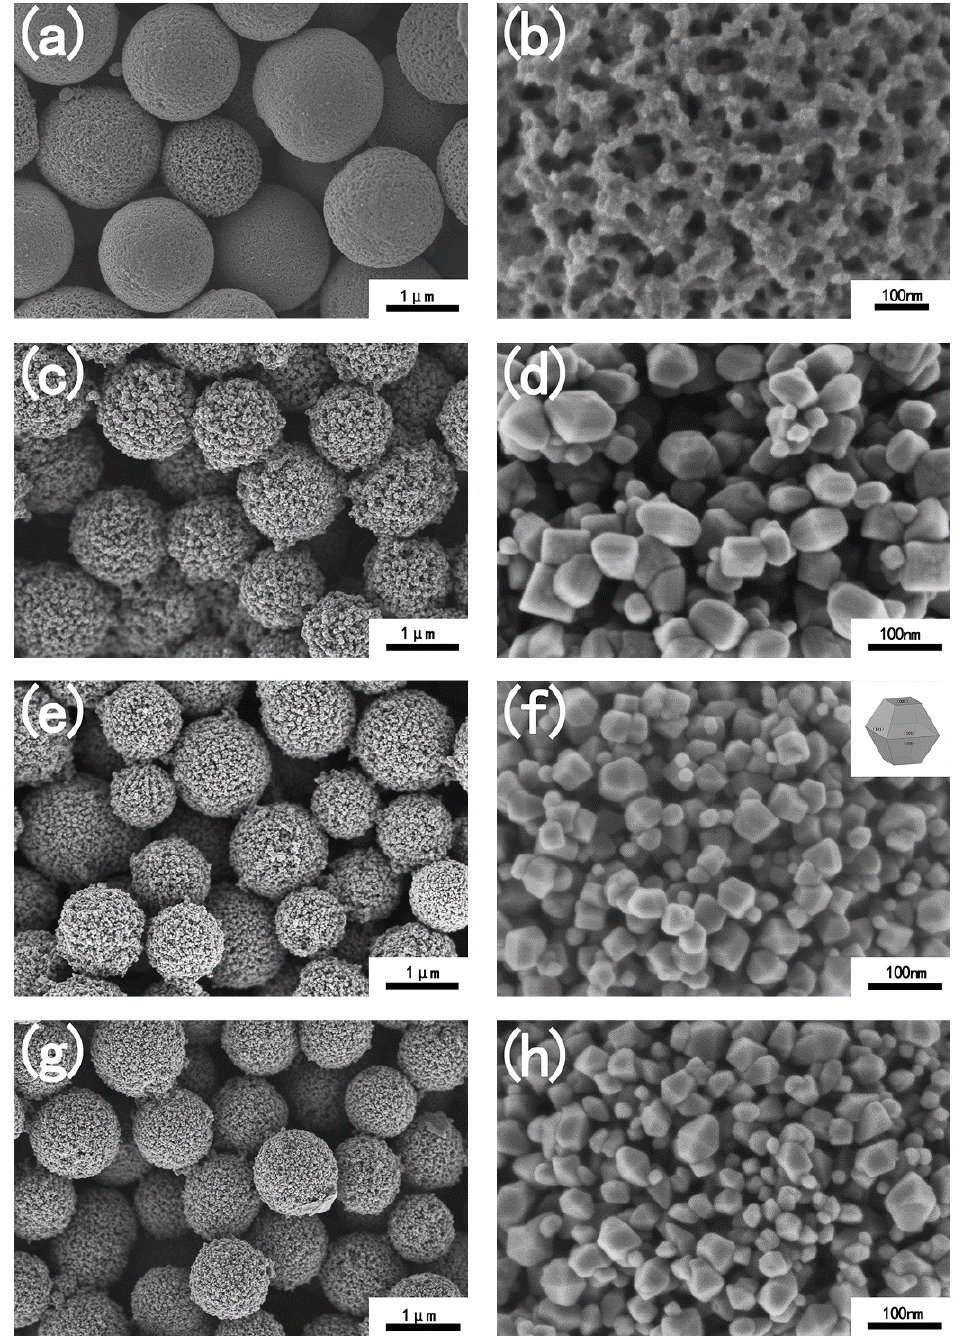
Figure 1. FE-SEM images of: ( a , b ) precursor S pm microballs, and ( c – f ) faceted microballs: Et-4 mL ( c , d ), Et-6 mL ( e , f ) and Et-8 mL ( g , h ); and (inset in f ) the schematic illustration of decahedral anatase particles.